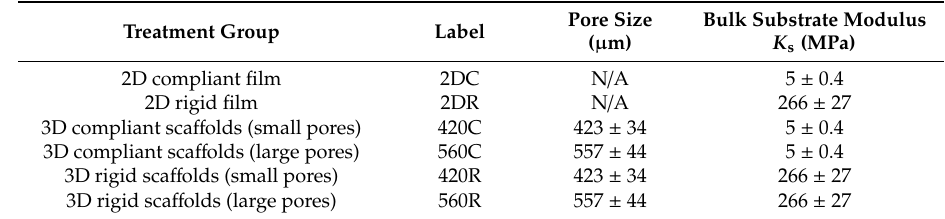
Table 1. 3D sca ff old characterization and in vitro study design. Material characterization and nomenclature of 2D films and 3D sca ff